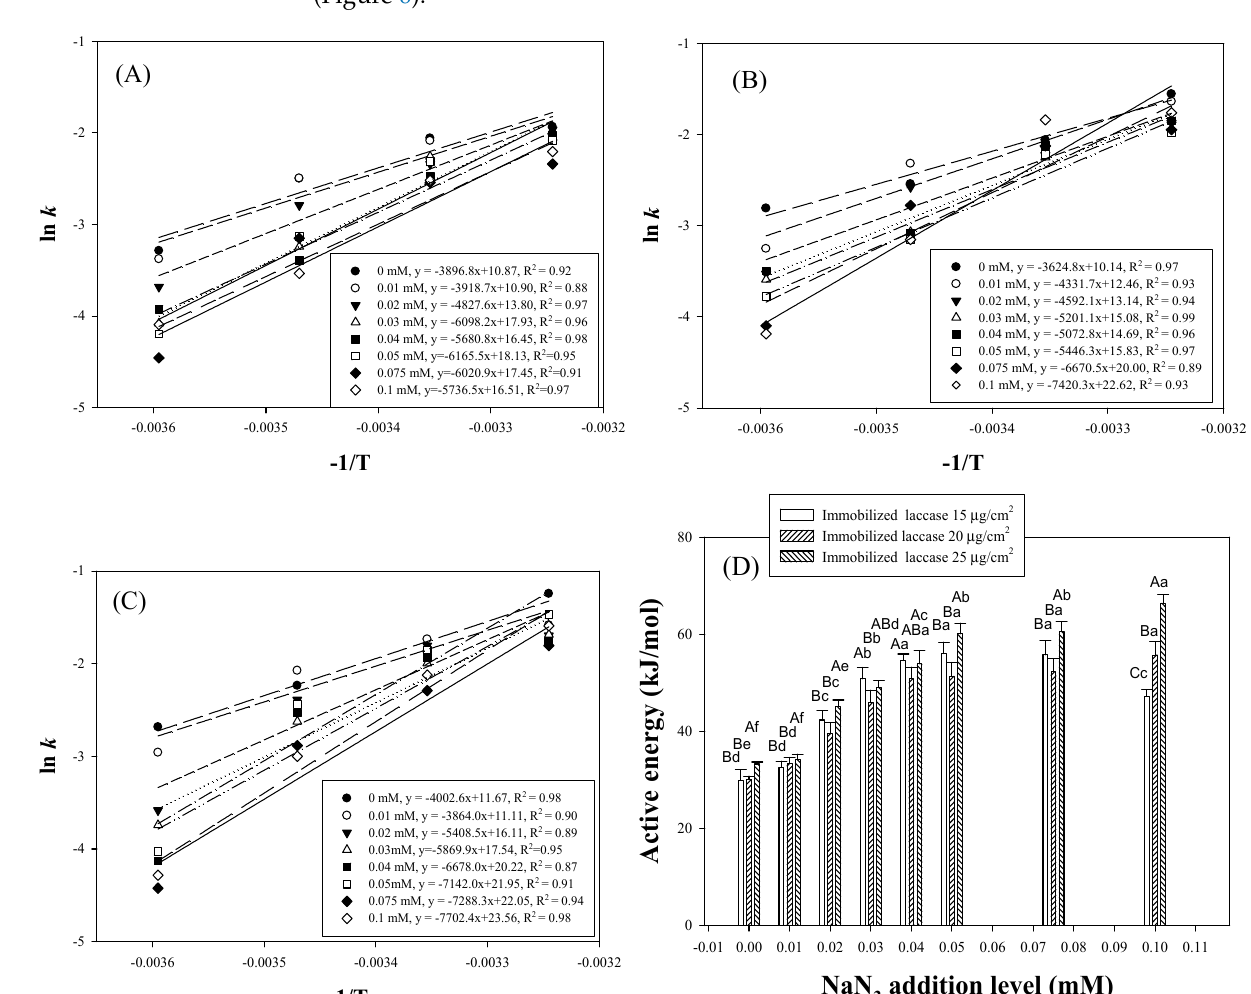
Figure 6. Coloration rate constant of TTI prototypes containing ( A ) 15, ( B ) 20, and ( C ) 25 µ g/cm 2 laccase, 0–0.1 mM N-HGG, and 0–0.1 mM N-HGG; ( D ) Arrhenius activation energy ( Ea ) of the laccase TTI prototype. ( A – C ): significant difference in Ea with respect to the quantity of enzyme immobilized; a–f: significant difference in Ea with respect to the amount of NaN 3 added ( p < 0.05).